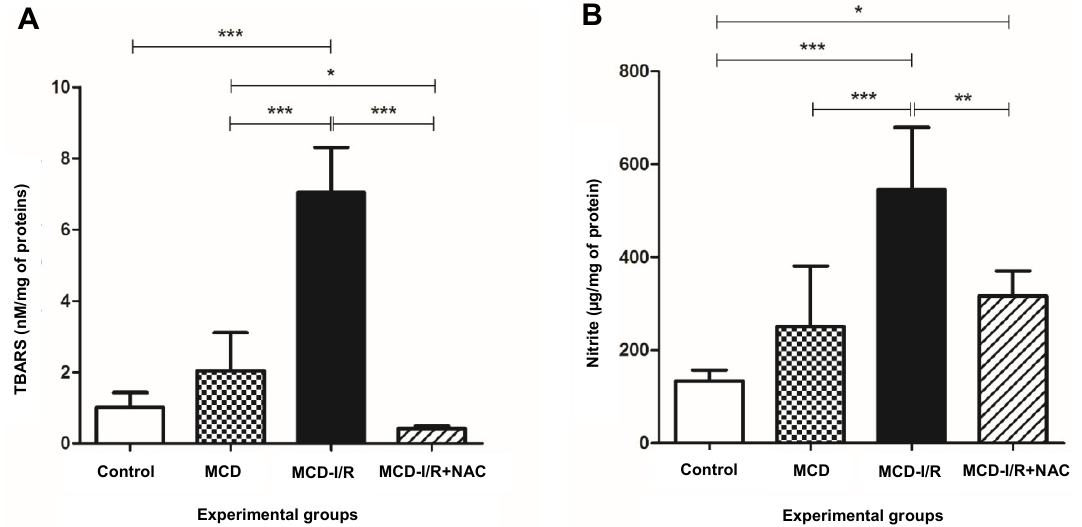
Figure 2. Concentrations of thiobarbituric acid reactive substances (TBARS) and nitrite in the liver of normal mice and of animals submitted to I / R in the MCD diet treated or not with N -acetylcysteine. The figure shows the levels of ( A ) TBARS and ( B ) nitrite (* p < 0.05, ** p < 0.01, and *** p < 0.001; N = 5–6; Bonferroni one-way ANOVA).